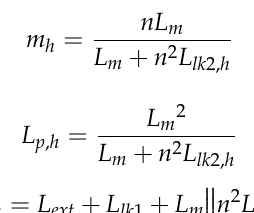
Figure 5. Equivalent circuit models of the resonant tank during the positive cycle (lower left) and negative cycle (lower right). The voltage gain during the positive and negative cycles can be expressed as follows 2